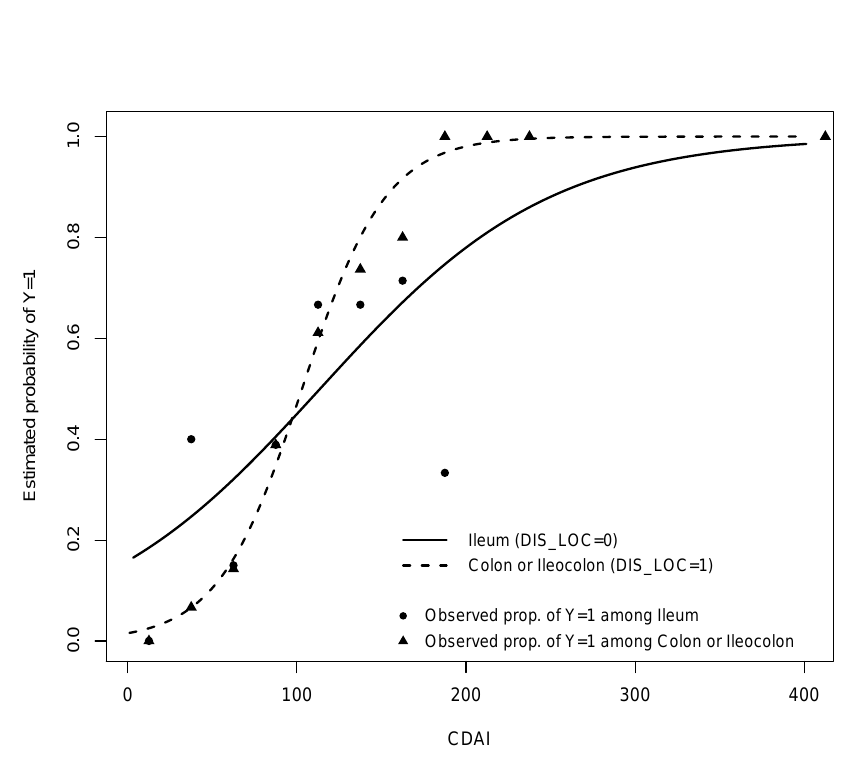
Figure 1 – Estimated probability curves and observed proportions stratified for DIS LOC versus CDAI